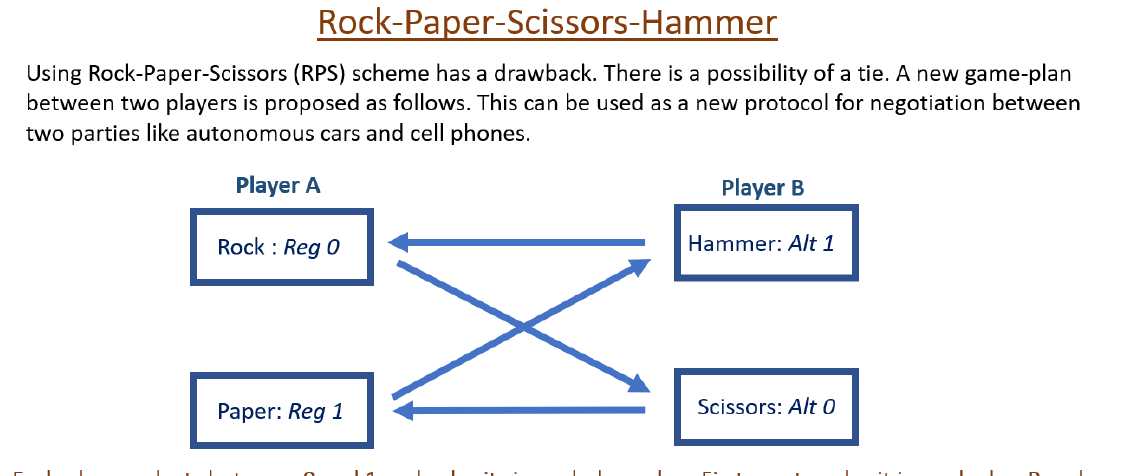
Figure 3. Rock-Paper-Scissors-Hammer protocol (RPSH).